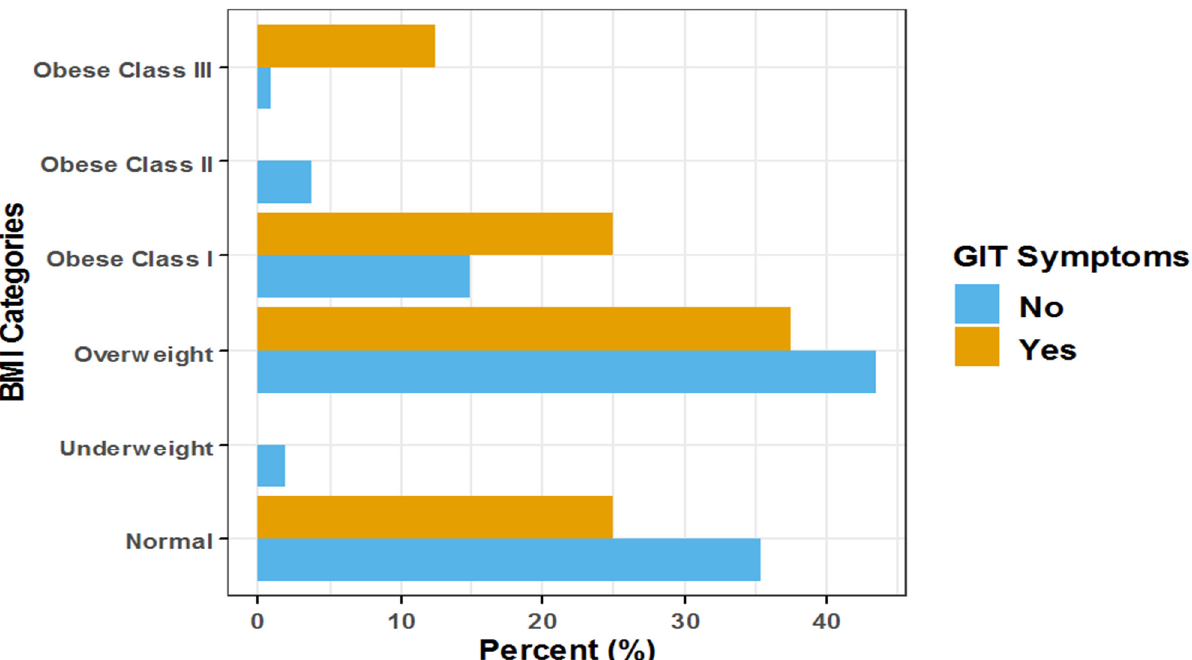
Figure 8. Forest plot for the association between BMI and the incidence of gastrointestinal symptoms among hospitalized COVID ‐ 19 patients. BMI: body mass index; GIT: gastrointestinal tract infection.